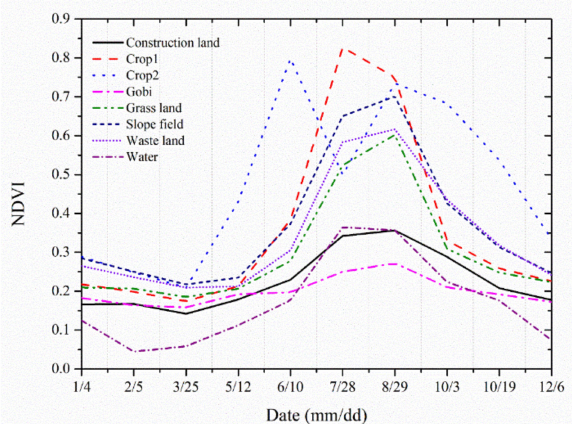
Figure 7. The reference NDVI curves of MODIS selected by samples in AHB dataset.